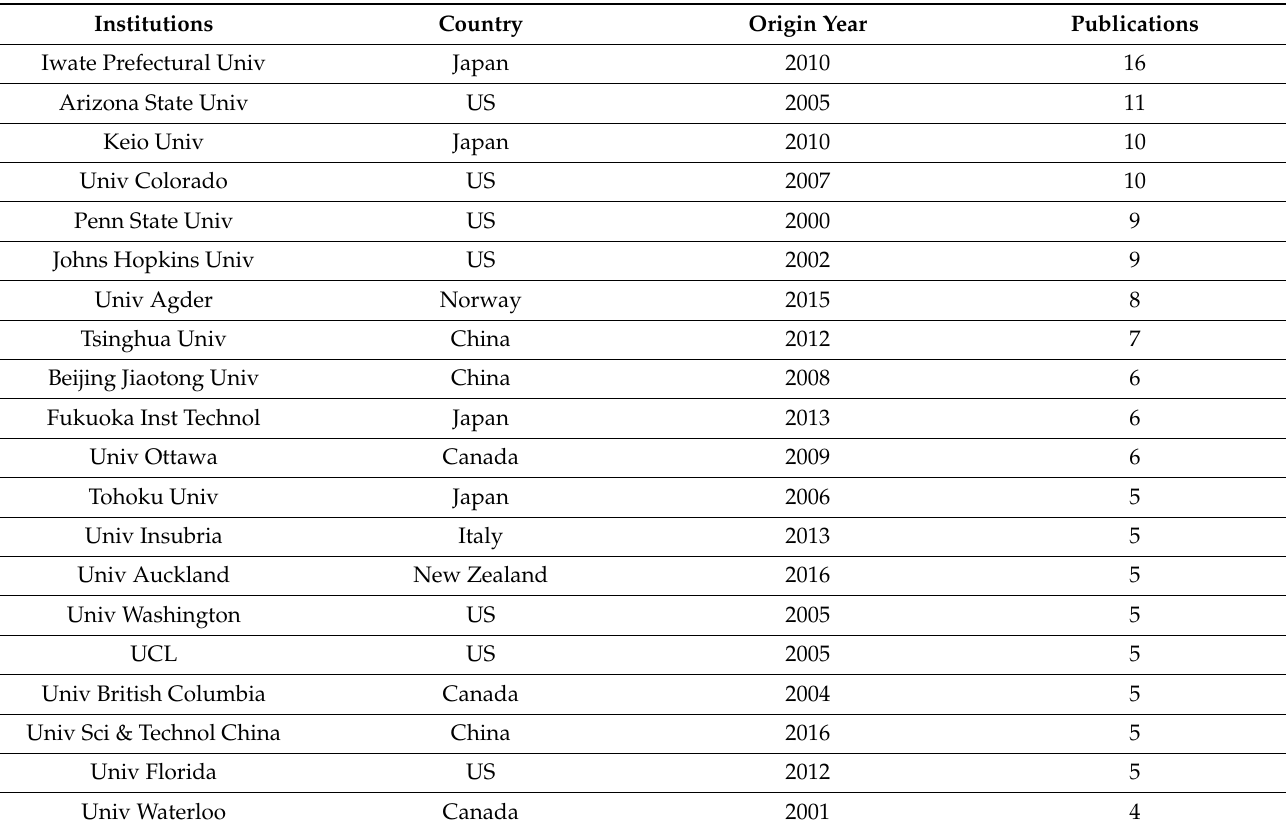
Table 2. Top 20 contributing